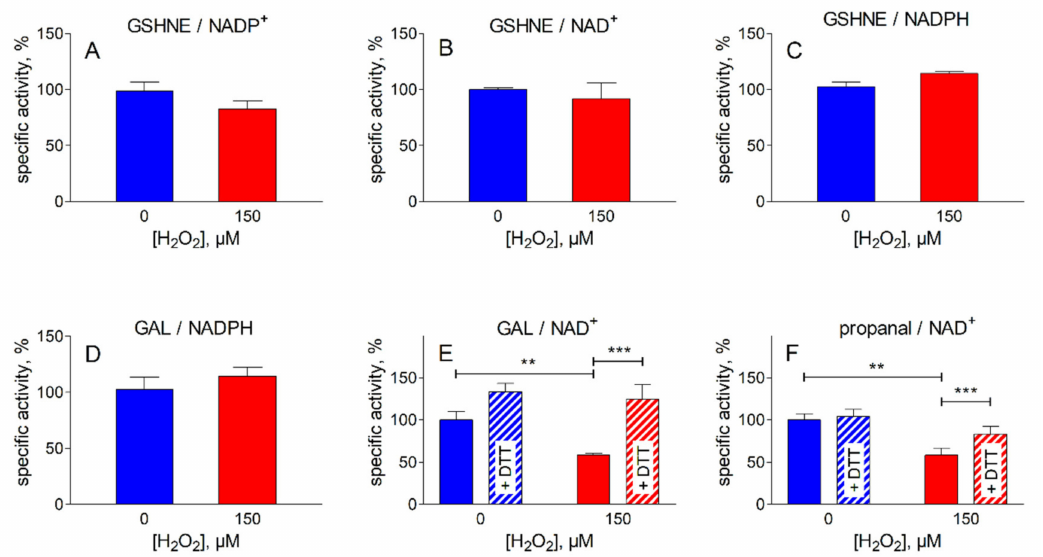
Figure 2. E ff ect of peroxidative treatment on oxidoreductase activities present in ADF cells. The cells were subjected to the treatment with H 2 O 2 as described in Figure 1, using 150 µ M of H 2 O 2 . The following activities were measured in ADF crude extracts as described in Section 2.5 before (blue bars) or after the oxidative treatment (red bars). NADP + -dependent ( A ) and NAD + -dependent ( B ) oxidation of glutathionylhydroxynonanal (GSHNE); NADPH-dependent reduction of GSHNE ( C ); NADPH-dependent reduction of glyceraldehyde (GAL) ( D ); NAD + -dependent oxidation of GAL ( E ) or propanal ( F ). Dashed bars refer to the activity values measured after incubation of the indicated sample for 60 min at 37 ◦ C in the presence of 2 mM dithiothreitol (DTT). The values are expressed as % of the specific activity measured in control cells (incubated in the absence of the peroxide) and are the mean ± SEM of at least three independent experiments. Significance was evaluated with respect to the treatment indicated. (** p < 0.01; *** p <